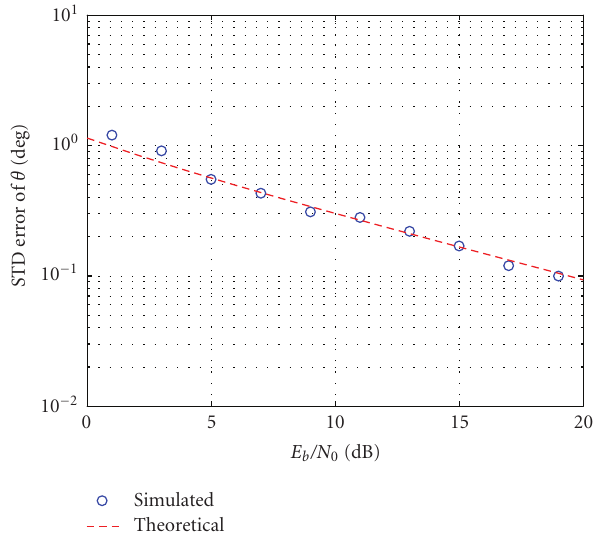
Figure 10: Standard deviation of DOA estimation error (stationary tag, single frame).